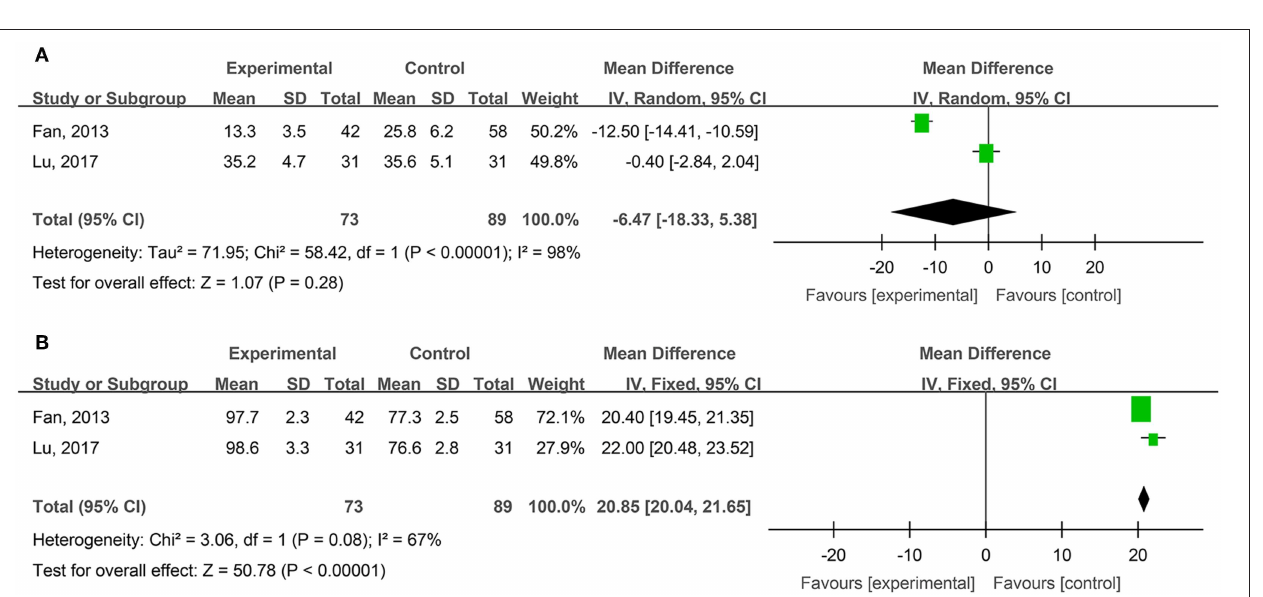
FIGURE 8 | Comparative meta-analysis of WHO pain ratings of traumatic skin injuries.